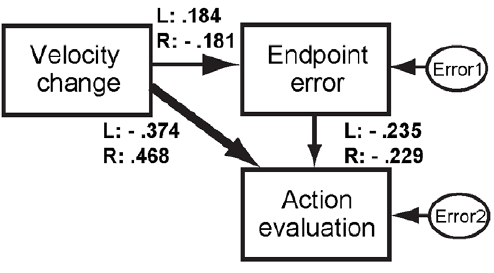
Figure 6. Path diagram in the practice phase. Path analysis was applied to the data of each participant. Velocity change denotes the data of the X velocity of the 100-ms-time window corresponding to the gray area in Fig. 3B (i.e., 200 , 300 ms after the prime onset), Endpoint error denotes the endpoint errors, and action evaluation denotes the action evaluation scores reported after each trial. The line width between the variables schematically indicates the strength of the relationship, and each number near the path denotes the mean standardized path coefficient of Mask L and R conditions respectively (see also Table 1).